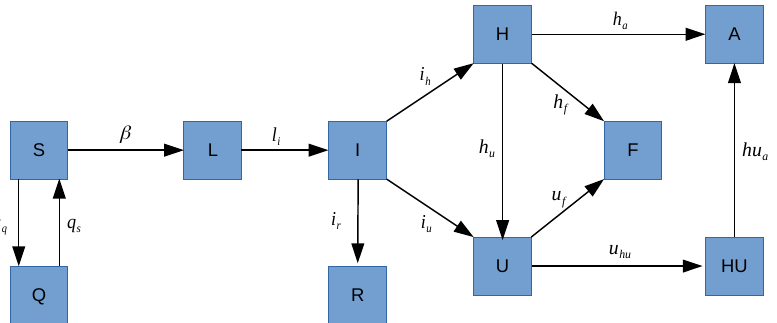
Figure 1. Flow diagram of the COVID-19 transmission dynamics. The boxes represent the states of individuals respect to the disease, and the letters next to the arrows represent the transition rates between